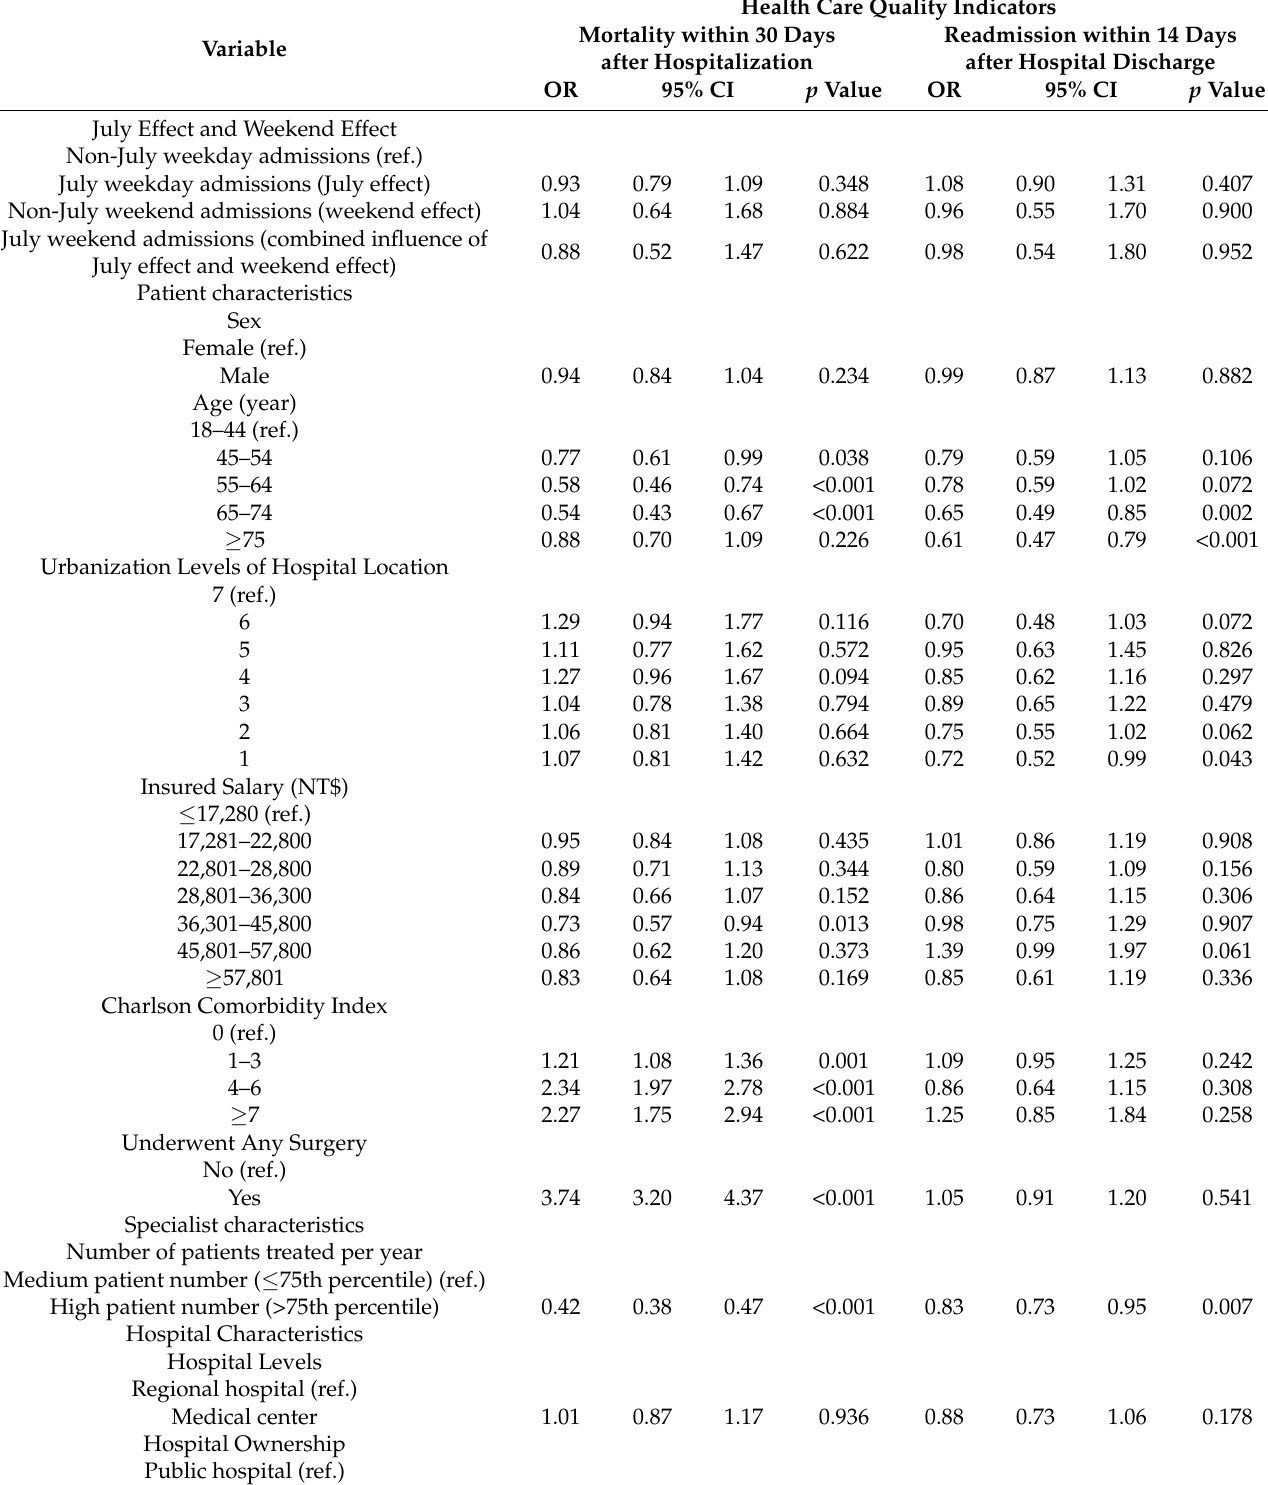
Table 2. Logistic regression analysis with GEE models for the July effect and weekend effect on mortality rate within 30 days after hospitalization or readmission rate within 14 days after hospital discharge in patients with stroke. Health Care Quality Indicators Mortality within 30 Days Variable after